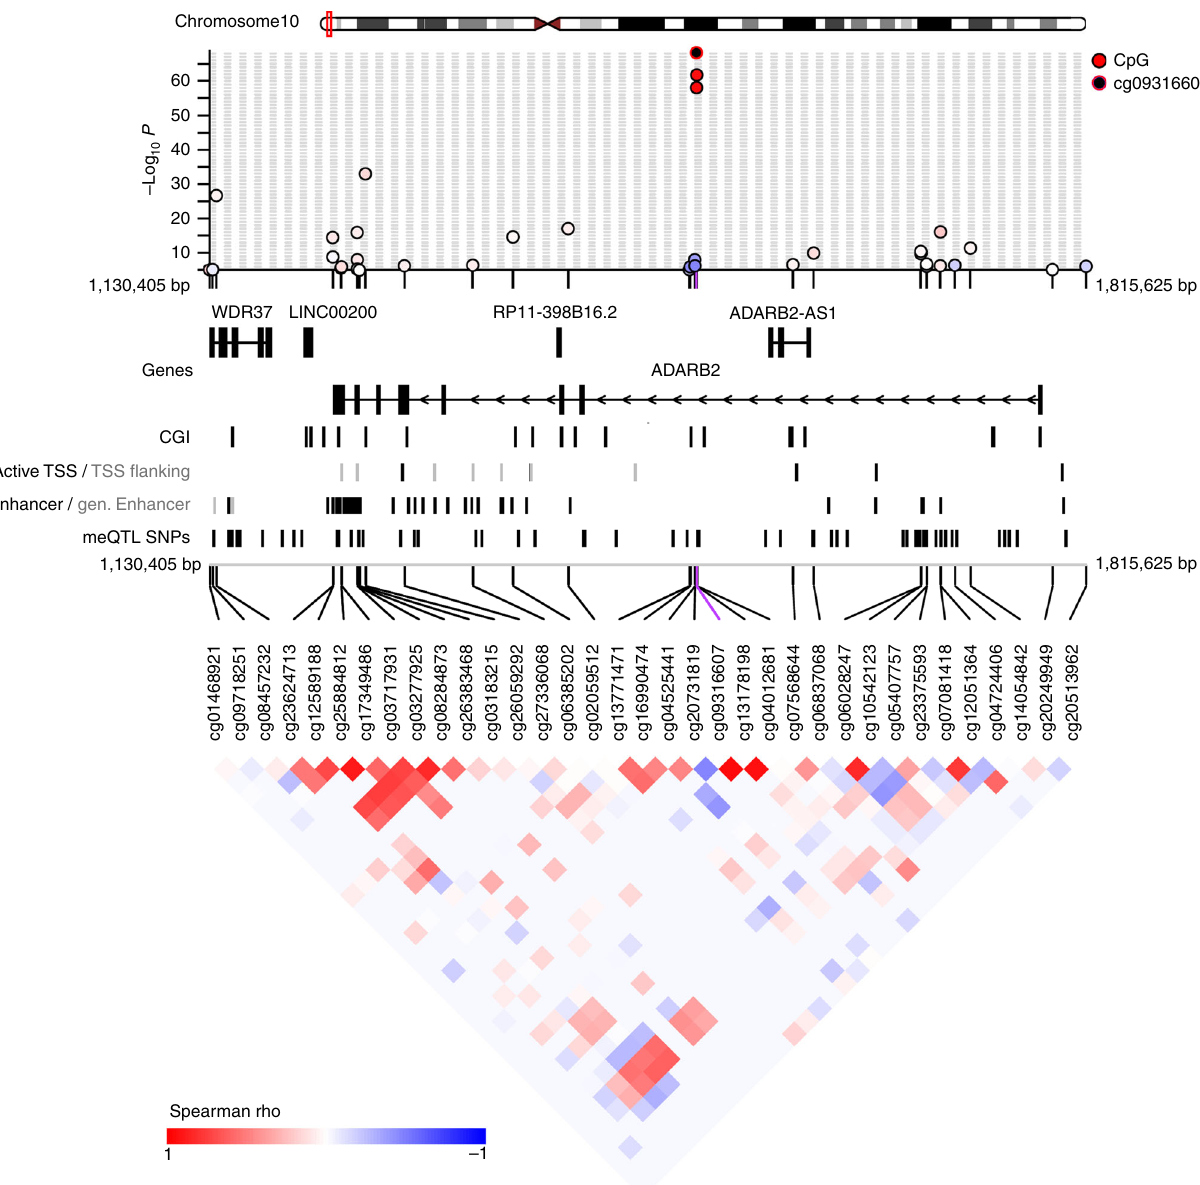
Fig. 2 Genomic organization of hippocampal cis -meQTLs at the ADARB2 locus. Regional plot of hippocampal cis -meQTL P -values and CpG co-methylation patterns in the chromosomal region 10p15.3 (chr10:1,130,405 – 1,815,625, hg19) encompassing the RNA-editing adenosine deaminase-2 gene ( ADARB2 ). We display gene symbols (Ensembl), CpG islands (UCSC), the Roadmap Hippocampus middle (E071) 15-chromatin-states: active TSS (#1 TssA, black), fl anking active TSS (#2 TssAFlnk, gray), enhancer (#7 Enh, black), genic enhancers (#6 EnhG, gray) and cis -meQTL-SNPs. The plot was created